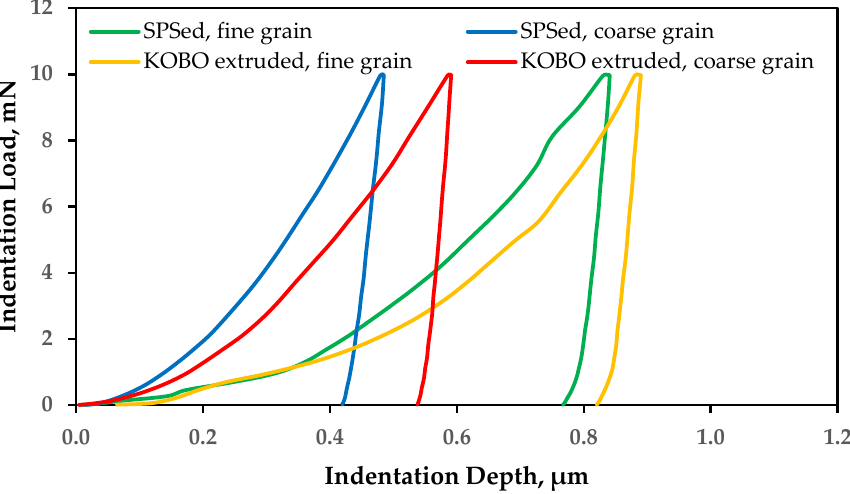
Figure 10. Nanoindentation curves obtained in coarse and fine grains of SPSed and SPS-KOBO extruded AA7075.